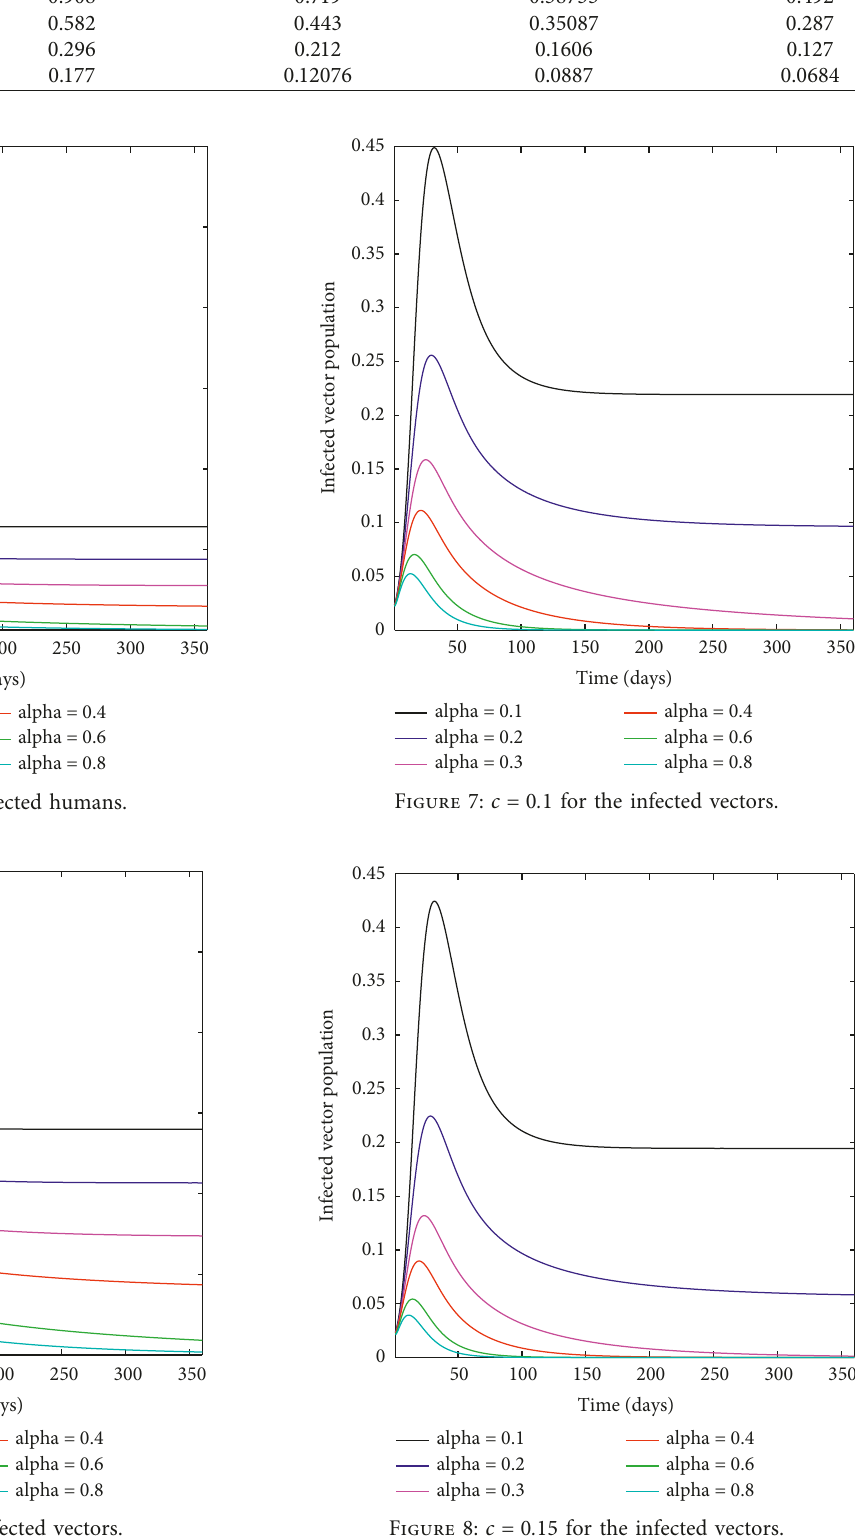
Figure 8: c � 0 . 15 for the infected